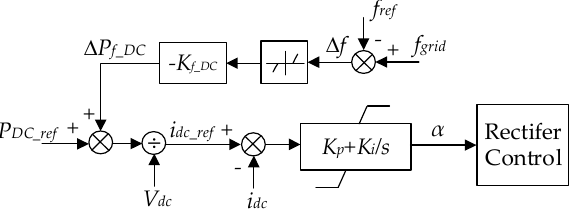
Figure 5. Frequency–power droop control for the HVDC rectifier convertor.